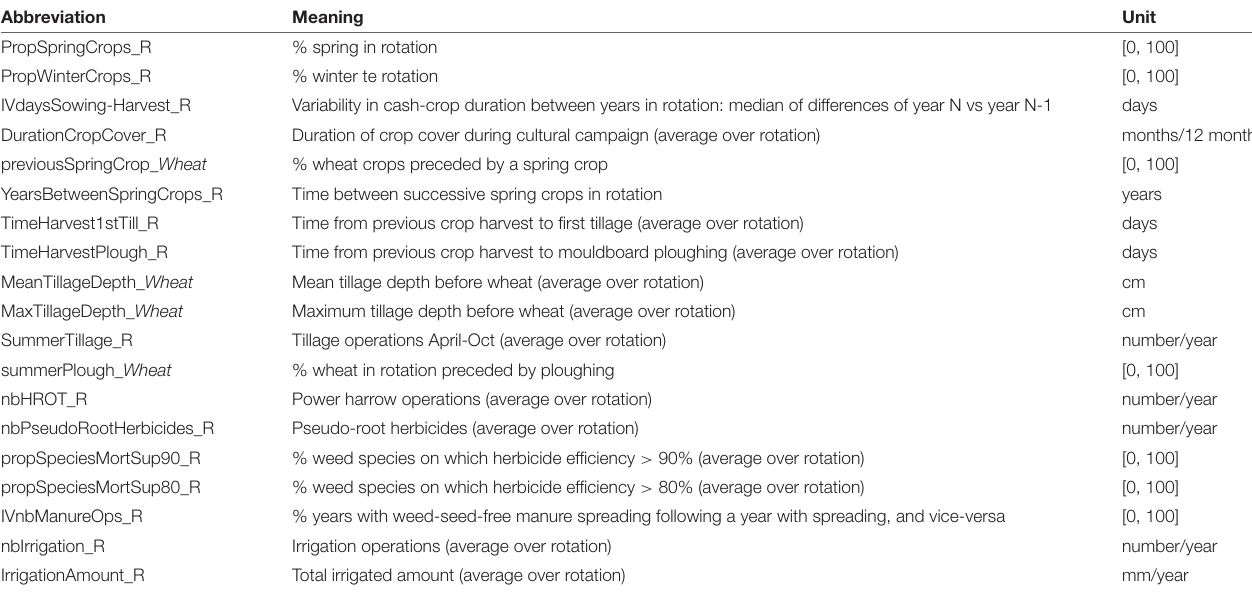
TABLE A2 | Explanations of key cropping techniques that drive increase in weed densities when tillage is deleted without compensation, based on the RLQ and 4th-corner analyses of Figure 5